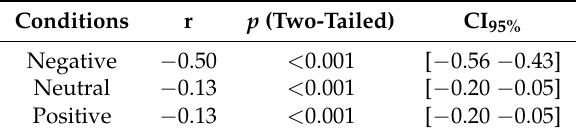
Table A3. Bootstrap (10,000 simulation runs) 95.0% confidence intervals (CI) associated with the Spearman correlation between MSE1s (i.e., 62 MSE1s associated with 62 EEG channels of a participant, per affect) and DE (i.e., 62 DEs associated with 62 EEG channels of a participant, per affect) in the negative, neutral, and positive mental